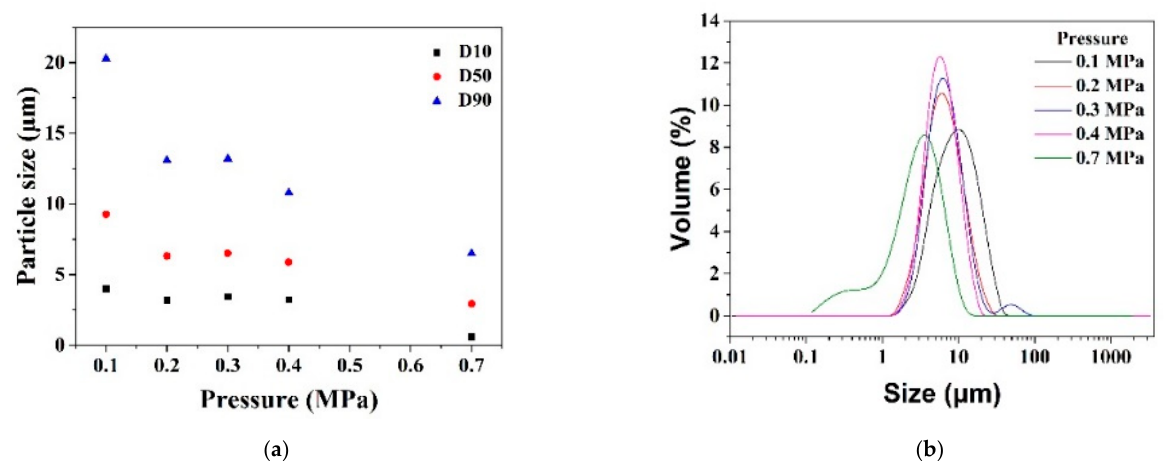
Figure 11. Effect of pressure on particle size. ( a ) average particle size ( b ) particle size distribution